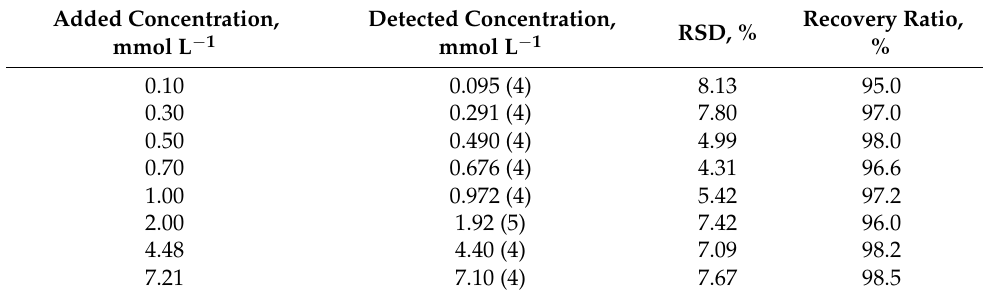
Table 2. The determination and recovery ratio of glucose in the serum sample were investigated by biosensors based on the GR/PANI-AuNPs (6 nm) -GOx/GOx electrode ( n —number of measurements, RSD—repeatability). Added Concentration, mmol L −